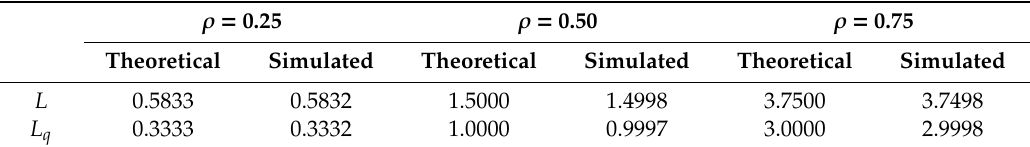
Table 1. Comparisons between theoretical and simulated results for L and L q